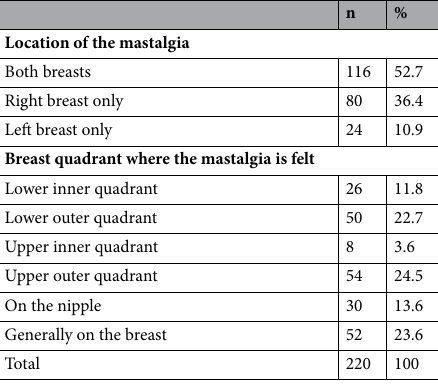
Table 2. Localization of the pain in the breasts of women with mastalgia. n number.